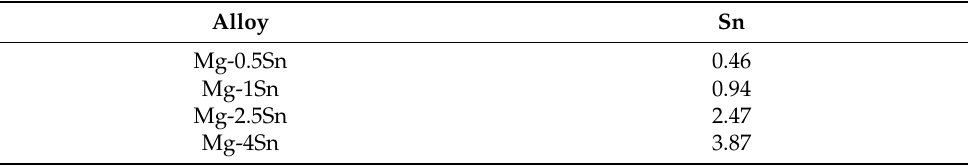
Table 1. Chemical compositions of experimental alloy